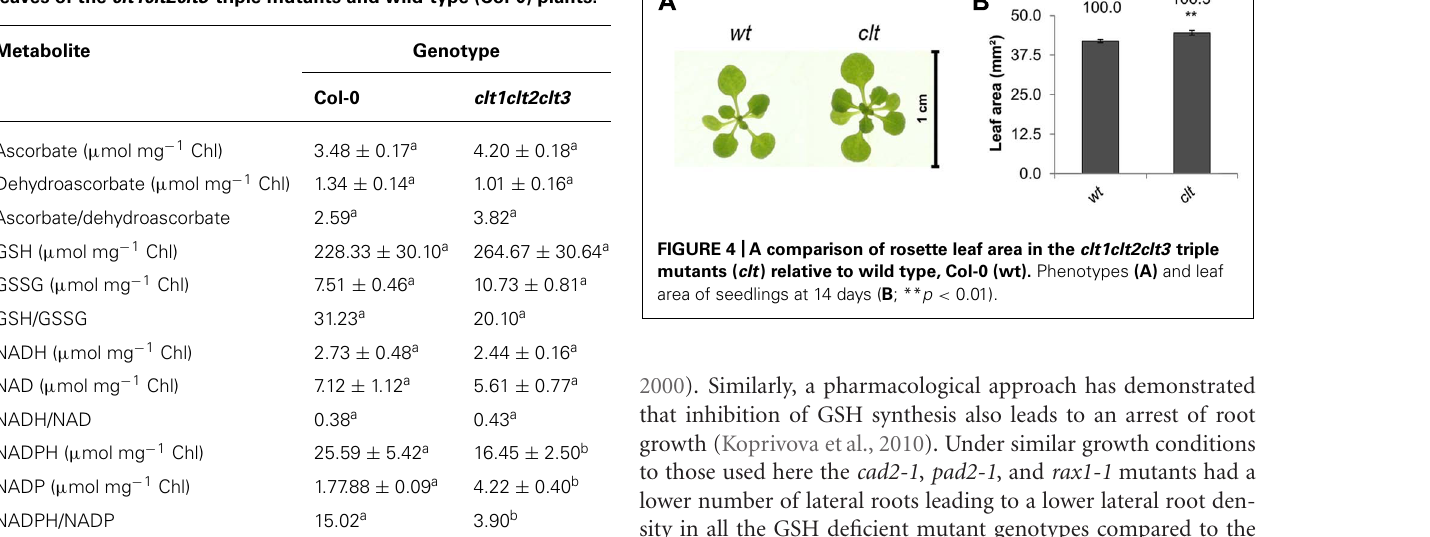
Values represent the mean values ± SE (n = 6). Values within a single row that were significantly different as estimated by Fishers protected LSD test (p < 0.05) are indicated by different letters.